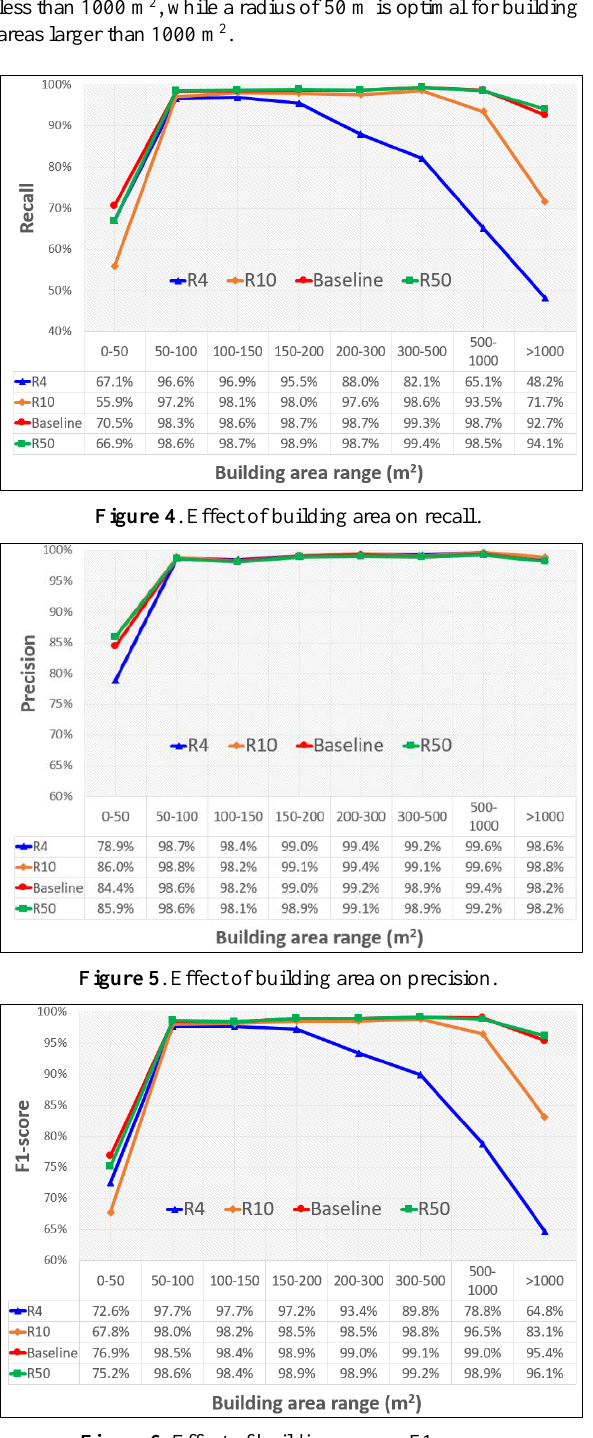
Figure 6 . Effect of building area on F1-score.